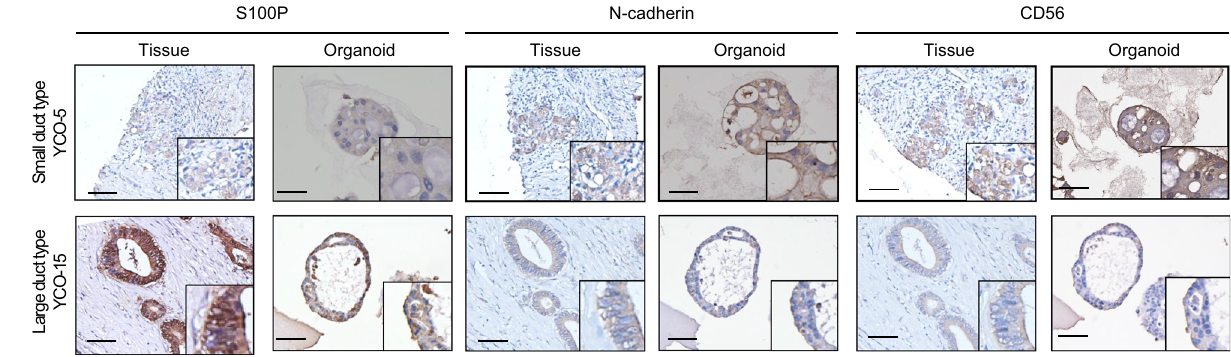
Fig. 2 | CharacteristicsofICC organoids. ICC tumor subtypeand paired organoid based on S100P, N-cadherin, and CD56 expression. LD type, S100P + ; SD type, N-cadherin + CD56 + ( n =16). The LD type shows glanular and columnar cells in